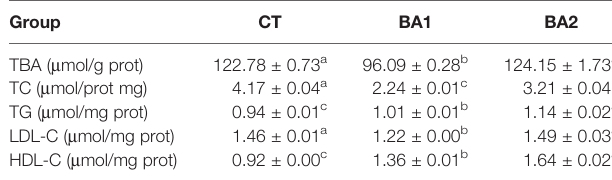
TABLE 5 | Effects of dietary bile acids on lipid metabolism in the liver in tongue sole.